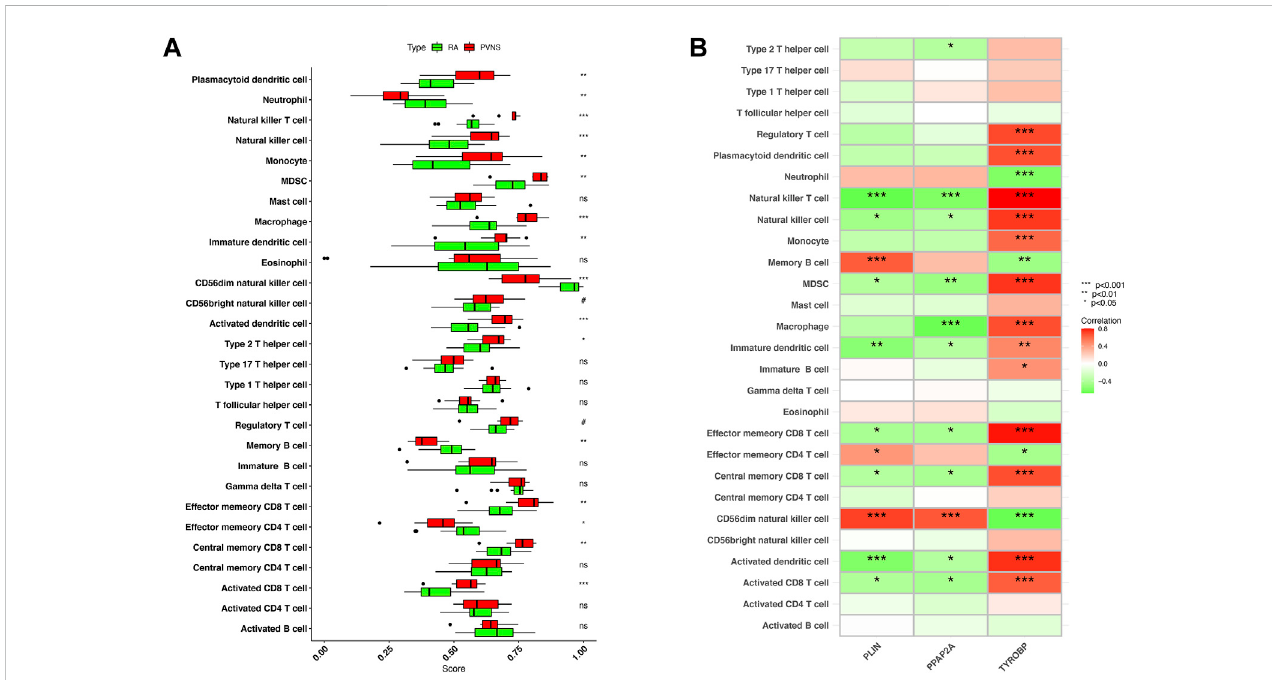
FIGURE 9 (A) Expressiondifferencesof28immunein fi ltratingcellsinsamplesofPVNSandRA (B) Correlationbetweenhubgenesandin fi ltratingimmunecells.Low p -values are green, whereas high ones are red. (nsP < 1, # p < 0.2, * p < 0.05, ** p < 0.01, *** p < 0.001).